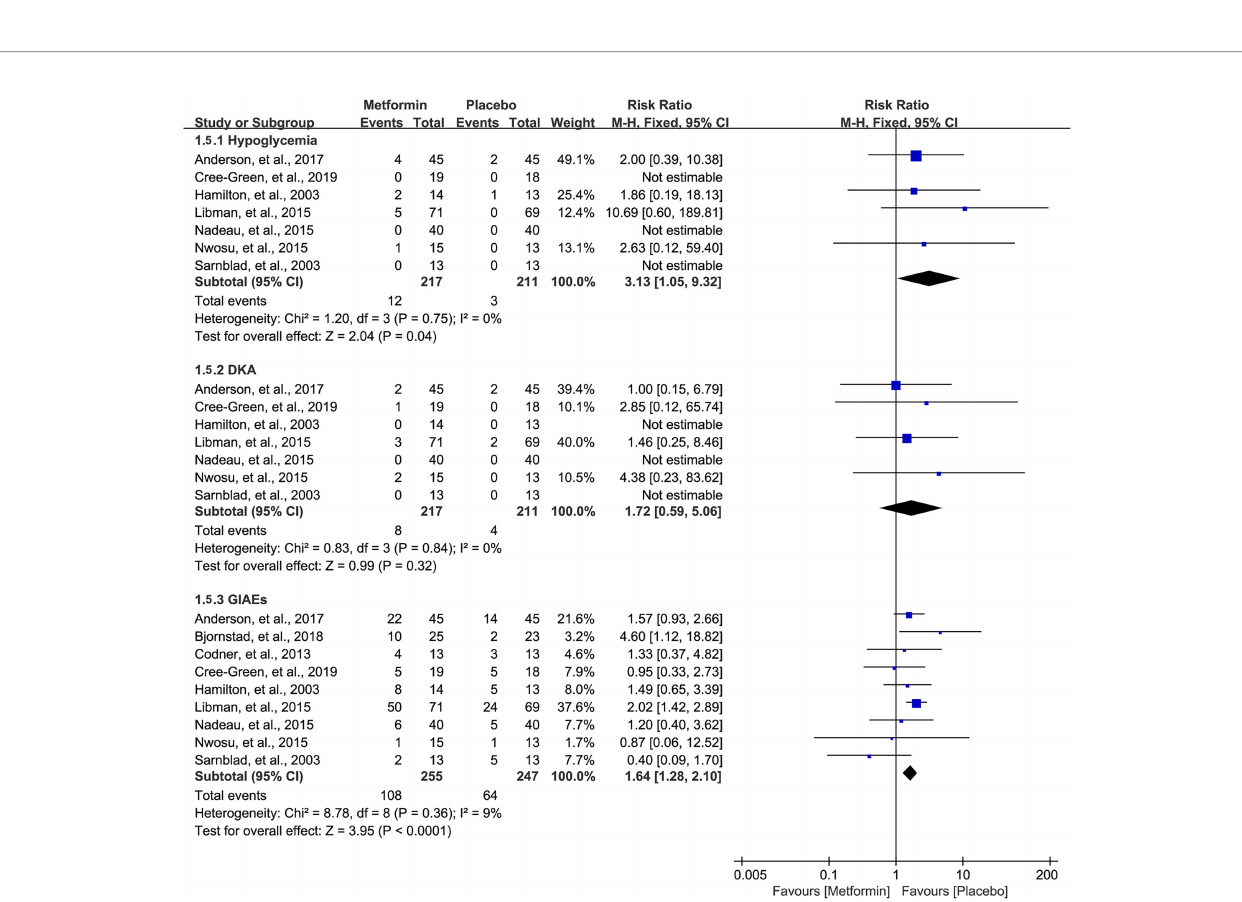
FIGURE 6 | Forest plot of the comparative safety between metformin and placebo in terms of adverse events during the treatment.